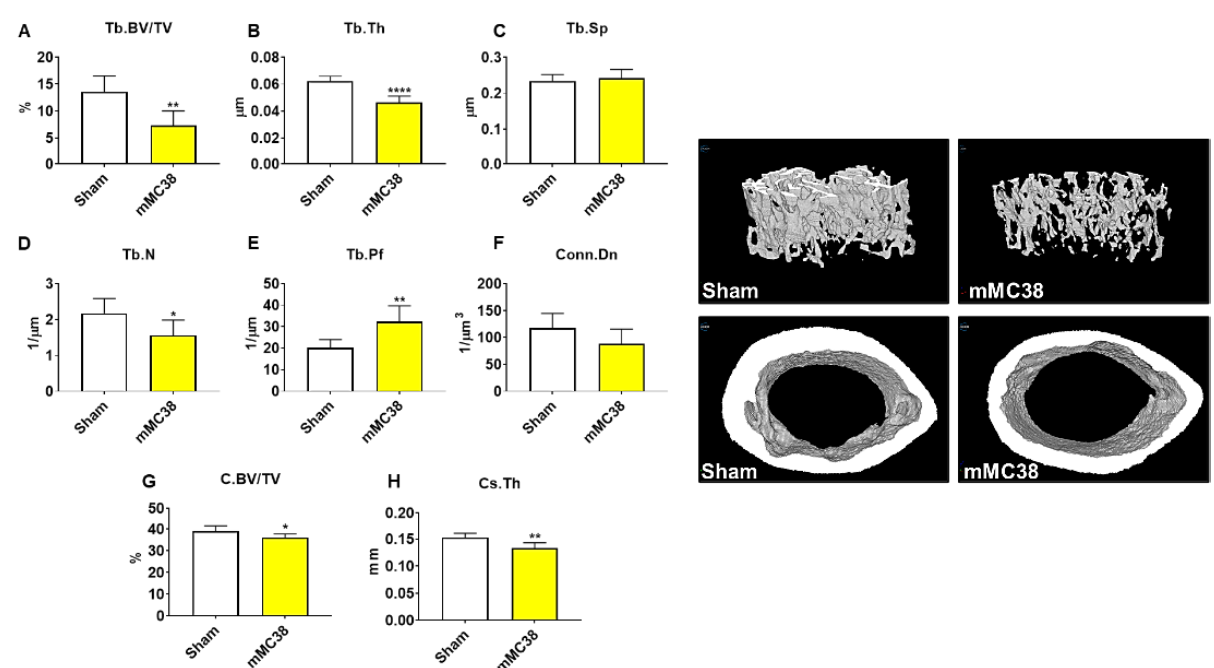
Figure 6. Formation of MC38 liver metastases causes loss of cancellous and cortical bone. Representative three-dimensional analysis of µ CT scanned images and quantification of trabecular bone volume fraction (Tb.BV/TV) ( A ), trabecular thickness (Tb.Th) ( B ), trabecular separation (Tb.Sp) ( C ), trabecular number (Tb.N) ( D ), trabecular pattern factor (Tb.Pf) ( E ), trabecular connectivity density (Conn.Dn) ( F ), cortical BV/TV ( G ) and cortical cross-sectional thickness (Cs.Th) ( H ) of femur bones from C57BL/6 male mice (8 weeks) intrasplenically injected with MC38 tumor cells (1.25 × 10 5 cells/mouse in sterile PBS: mMC38) or an equal volume of vehicle (sham) ( n = 5–8). Data presented as mean ± s.d. * p < 0.05, ** p < 0.01, **** p < 0.0001 vs. sham.